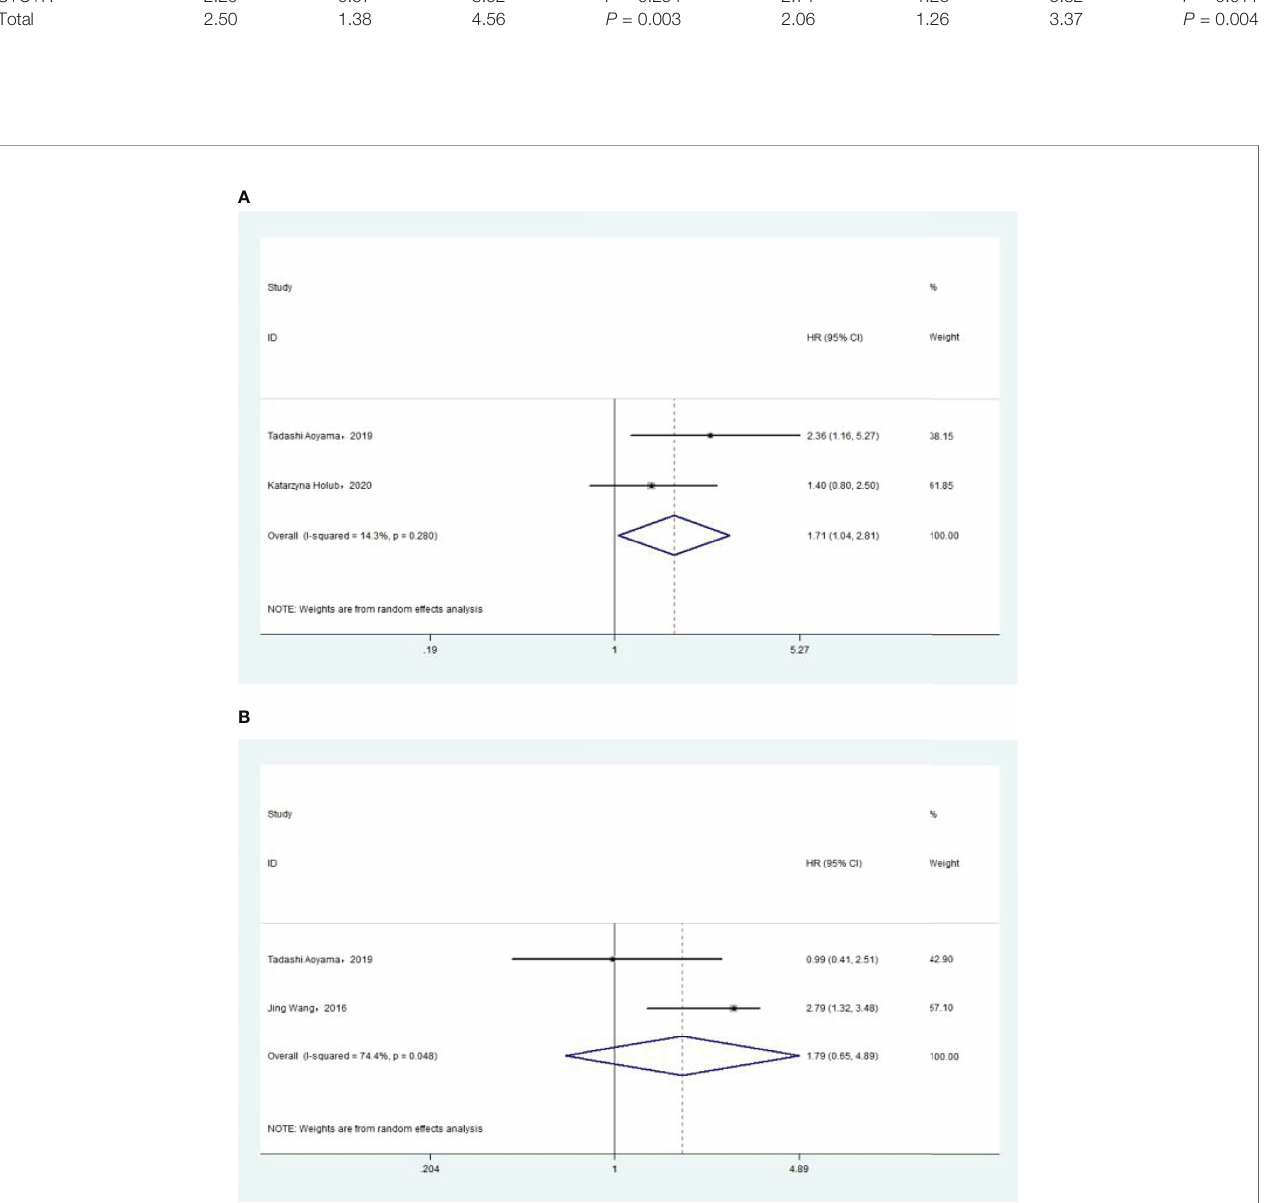
Frontiers in Oncology |